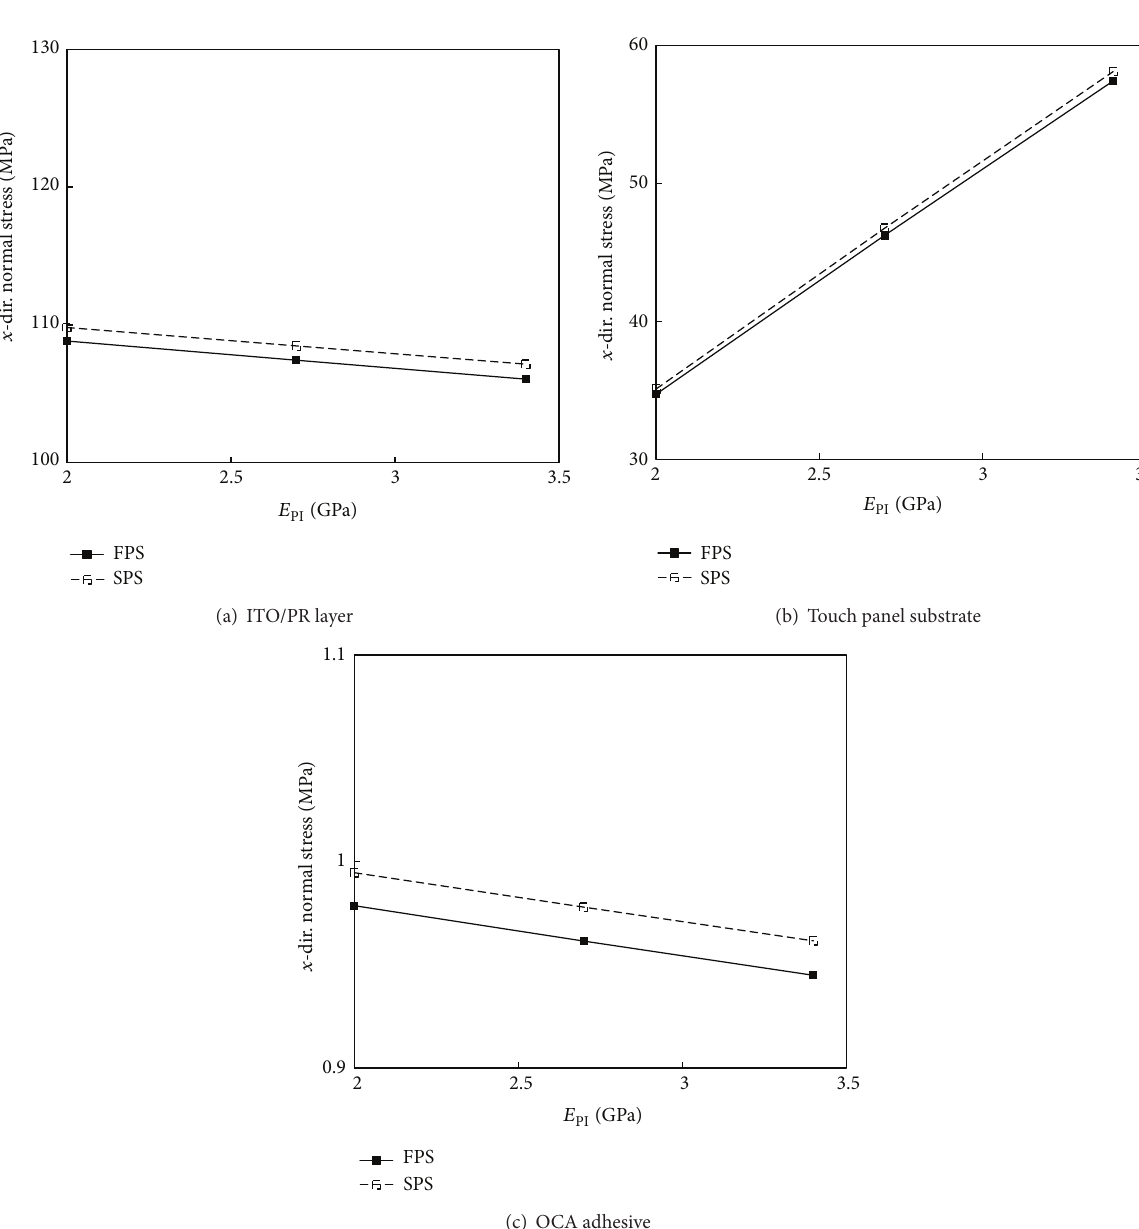
Figure 12: Effects of Young’s modulus of touch panel substrate on the bending stress of the components.